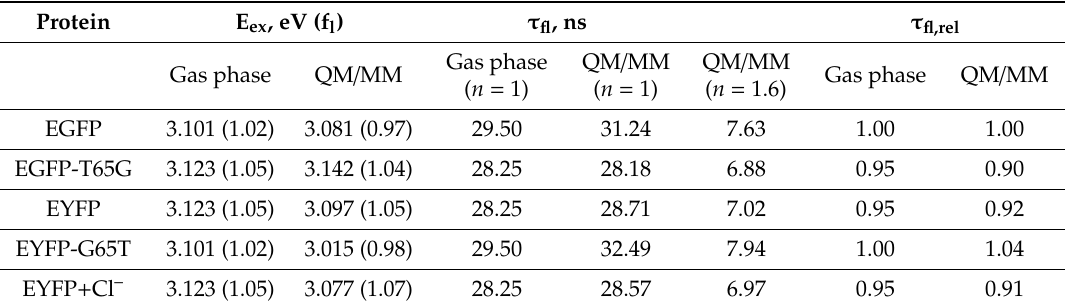
Table 3. Theoretical estimates of radiative lifetime for di ff erent mutants. Computed excitation energies and oscillator strengths are also shown. QM / MM absorption energies and oscillator strengths are averaged over 21 snapshots taken from ground-state equilibrium molecular dynamics simulations. τ fl,rel values are relative lifetimes calculated with respect to